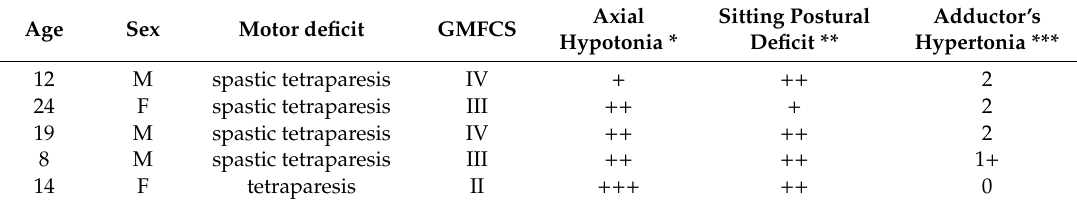
Table 1. Clinical characteristics of the recruited population.